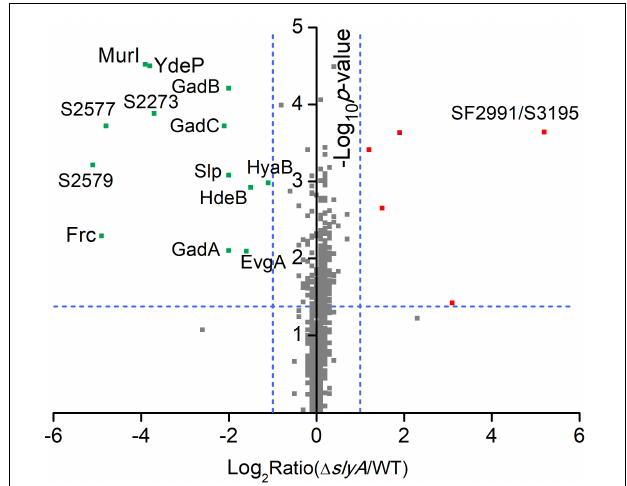
FIGURE 1 | Quantitative proteomic data of Shigella WT and (cid:49) slyA strains. A protein volcano plot was shown with the logarithmic values of the abundance ratios reported on the x -axis. The y -axis plots negative logarithmic p -values determined from the t -test on data from three biological replicates. Dotted lines denote two-fold (vertical) and p < 0.05 cutoff (horizontal). Proteins with homologous sequences may not be distinguished in LC-MS/MS experiments unless unique peptides were detected. As a result, the detection of SF2991 and S3195 is considered as a single protein identification (denoted as